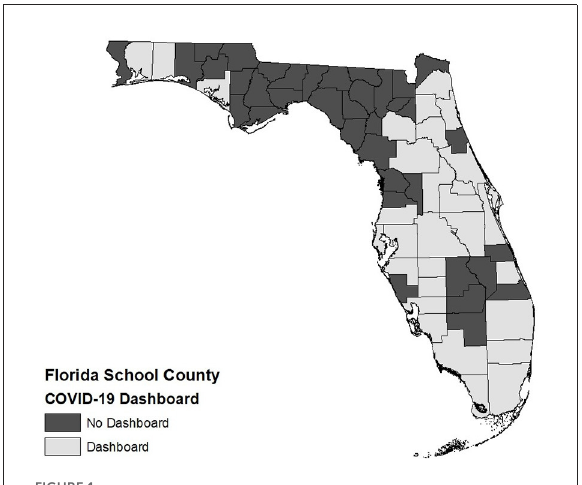
FIGURE1 Availability of COVID-19 dashboards in Florida Public School